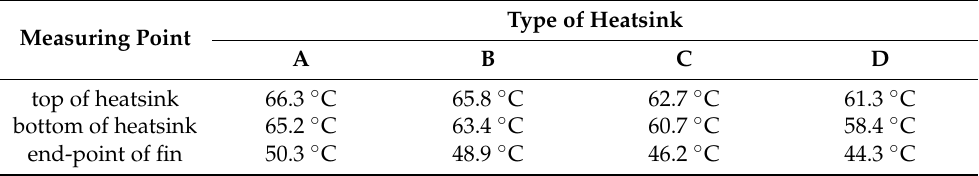
Table 3. Results of thermal analysis of four types of heatsink. Measuring